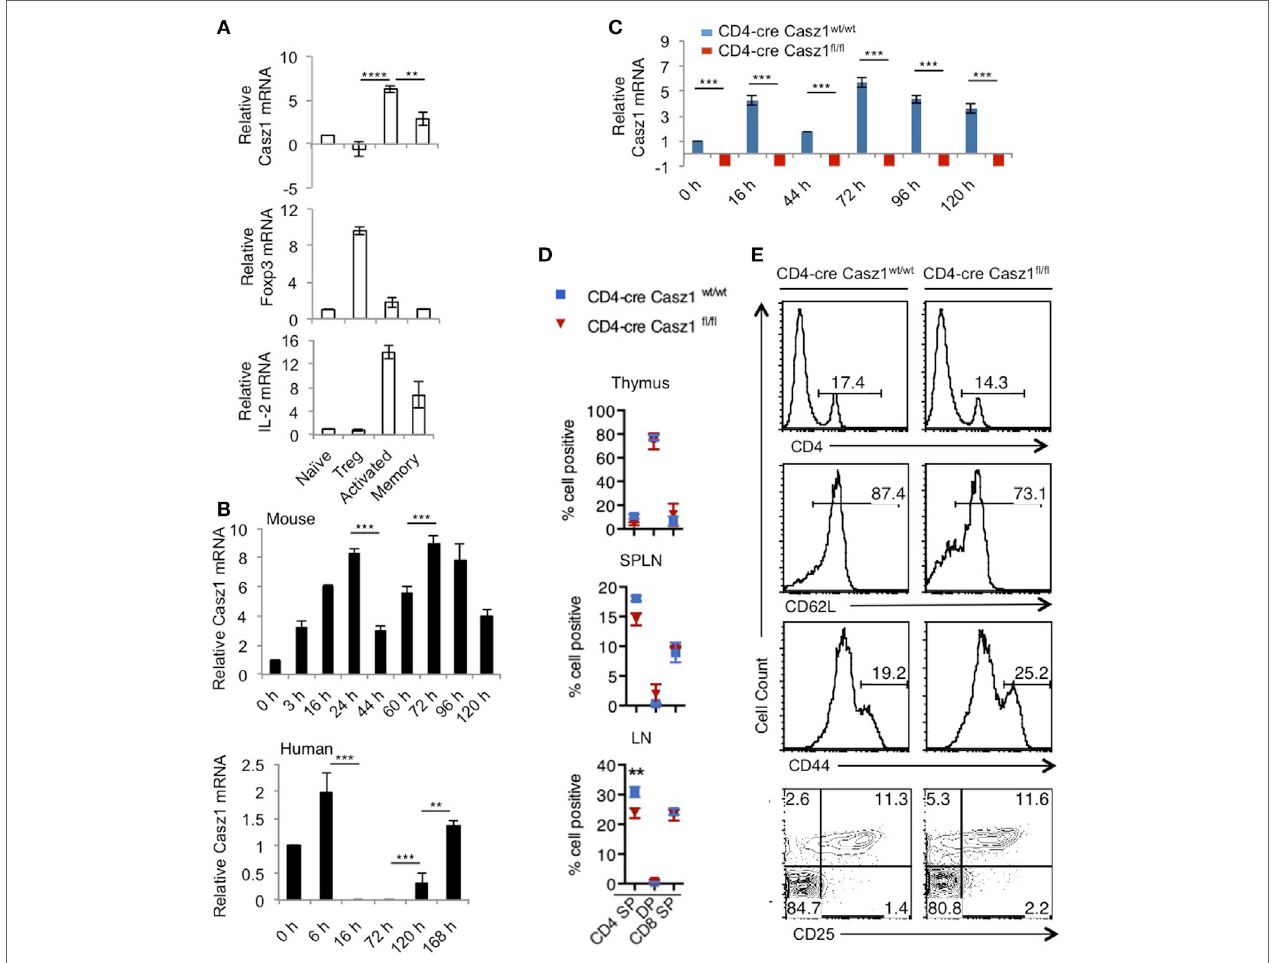
FigUre 1 | Casz1 mRNA expression in CD4 + T lymphocytes. RNA was isolated from fluorescence-activated cell sorting (FACS) sorted CD4 + CD25 − GFP − CD44 low (Naïve) cells, CD4 + CD25 + GFP + (regulatory T cells, T regs ), CD4 + CD44 high (effector/memory) cells pooled from spleen (SPLN) and lymph nodes (LN) of six Foxp3 GFP mice and used for Quantitative PCR (a) Naïve cells were stimulated with 1 µg/ml of plate-bound α -CD3 and 2 µg/ml of soluble α -CD28 antibodies for 3 days (activated) (a) , or for indicated times [ (B) , upper panel]. Human FACS sorted CD4 + CD25 − CD44 low CD45RA naïve cells were activated for indicated times [ (B) , lower panel]. Phenotype of CD4 conditional Casz1 knockout mice (c–e) . (c) Naïve CD4 + cells from WT (CD4-cre Casz1 wt/wt ) (blue), or knockout (CD4-cre Casz1 fl/fl ) (red) mice were stimulated for indicated times. (D) Single cell suspensions from thymus, SPLN, and LN from WT (blue) or knockout (red) mice (D) , or SPLN and LN pooled (e) , were used for flow cytometry staining in ex vivo [Gated on CD4 + T cells in second–fourth panels in (e) ]. Two-way ANOVA multiple comparison tests (a,B) , Student’s t -tests (c) , Two-way ANOVA multiple comparisons test (D) were performed to determine the significance. Data from one of three independent experiments are